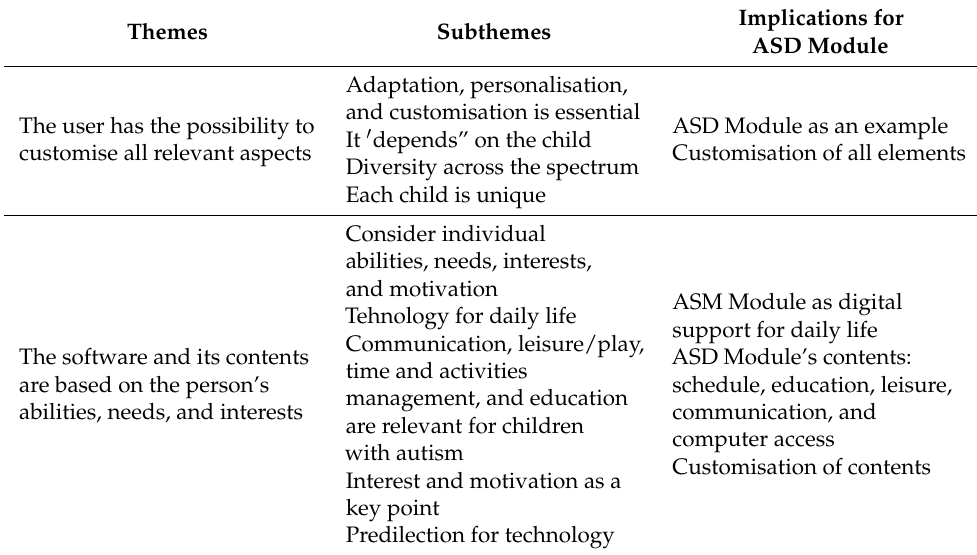
Table A1. Summary of Themes, sub-themes, and software